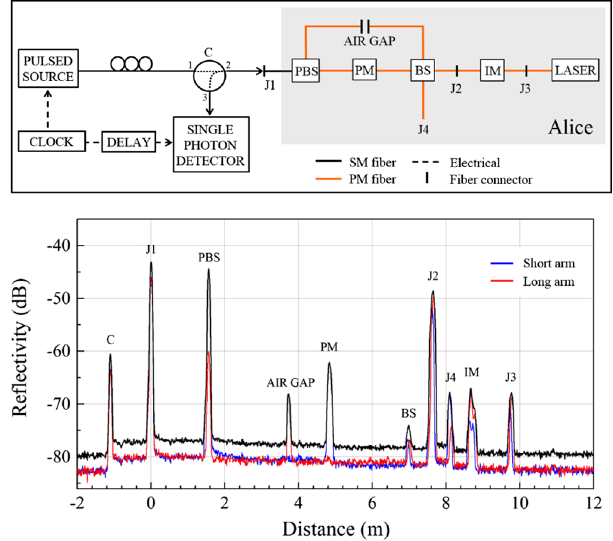
FIG. 6. Top panel: Schematics of the QKD transmitter module and of the ν -OTDR setup used for characterizing its reflectivity. Bottom panel: Reflection peaks of the transmitting unit. The distance is measured from the connector J1 placed at the entrance of the module. The traces are acquired for two orthogonal polarizations, aligned to maximize the transmission through the short (blue traces) and long (red traces) arms of the interferometer. The peaks of the reflectivity are added to obtain a worst-case estimation (black). Only the peaks from the components included in the shaded region of the top diagram have to be considered in the estimation of R considered in the estimation of R (see also dot-dashed line